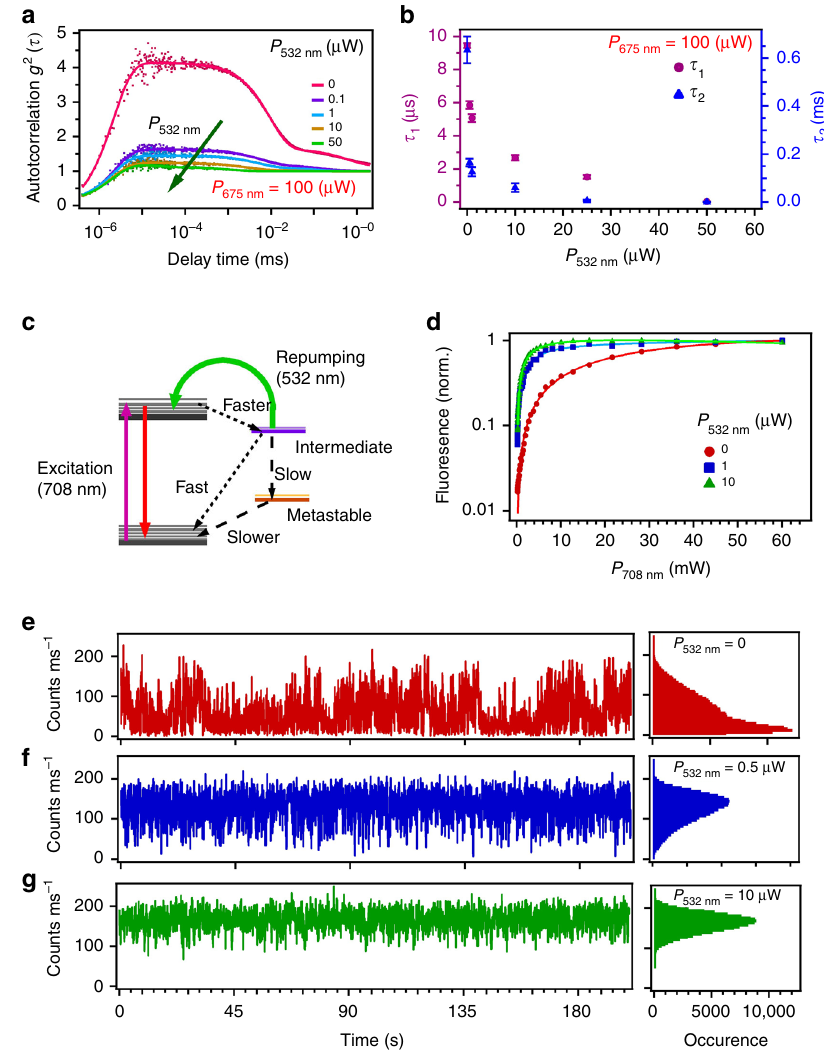
Fig. 2 Photo-physics of the single emitter introduced in Fig. 1. a Long autocorrelation measurements under excitation with a 675 nm laser (100 µ W). Increasing the power of a coincident laser (532 nm, green arrow) suppresses the population of the intermediate/metastable states due to repumping of the emitter (see main text). The experimental data (points) are fi tted (solid lines) using a four-level model. Error bars have been calculated based on the fi tting to the autocorrelation data. b Reduction in the time constants τ 1 and τ 2 associated with the intermediate/metastable states (extracted from the fi ts in a ; see Discussion in the main text) caused by increasing the power of the repumping 532 nm laser. c Simpli fi ed level structure of the emitter (see main text). The emitter possesses a ground state and excited state(s), as well as a fast-decaying intermediate and a long-lived metastable state. Radiative transitions are indicated by straight, solid arrows, repumping via the 532 nm laser is indicated by the green arrow, and fast and slow non-radiative transitions are indicated by dashed arrows. d The repumping causes a reduction in the laser power that is needed to saturate the emitter. e , f Fluorescence time trajectories of the emitter sampled into 100 ms bins, under excitation with 708 nm e or co-excitation with 708 and 532 nm lasers f , g . The power of the 708 nm laser was kept at 100 µ W and the power of the 532 nm repumping laser was 0.5 and 10 µ W in f and g , respectively. The corresponding histogram of the photon distribution at each excitation condition is shown on the